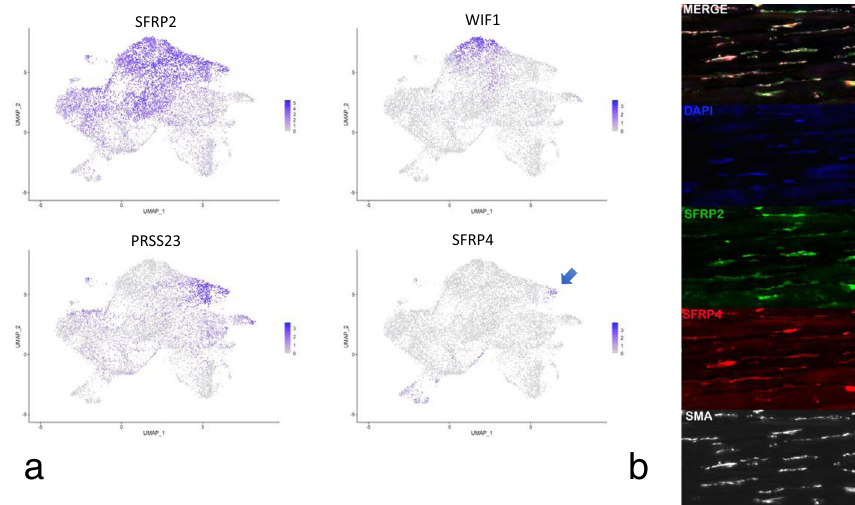
Fig. 4 Gene expression and immuno fl uorescent staining of fi broblasts and myo fi broblasts in SSc skin. Cells from combined analysis of healthy control ( n = 10) and SSc ( n = 12) mid-forearm skin biopsies. Purple indicates increased expression ( a ). SSc SFRP2 + fi broblasts express increased PRSS23, decreased WIF1, and the myo fi broblast subpopulation expresses SFRP4. Deep dermis from a patient with diffuse cutaneous SSc co-stained with SFRP2 (green) and SFRP4 (red), SMA (white) show strong overlap between staining of myo fi broblasts with SFRP2 and SFRP4 ( b ). Nuclei (purple) are stained with Hoechst. Staining representative of n = 5. Scale bar = 50 μ